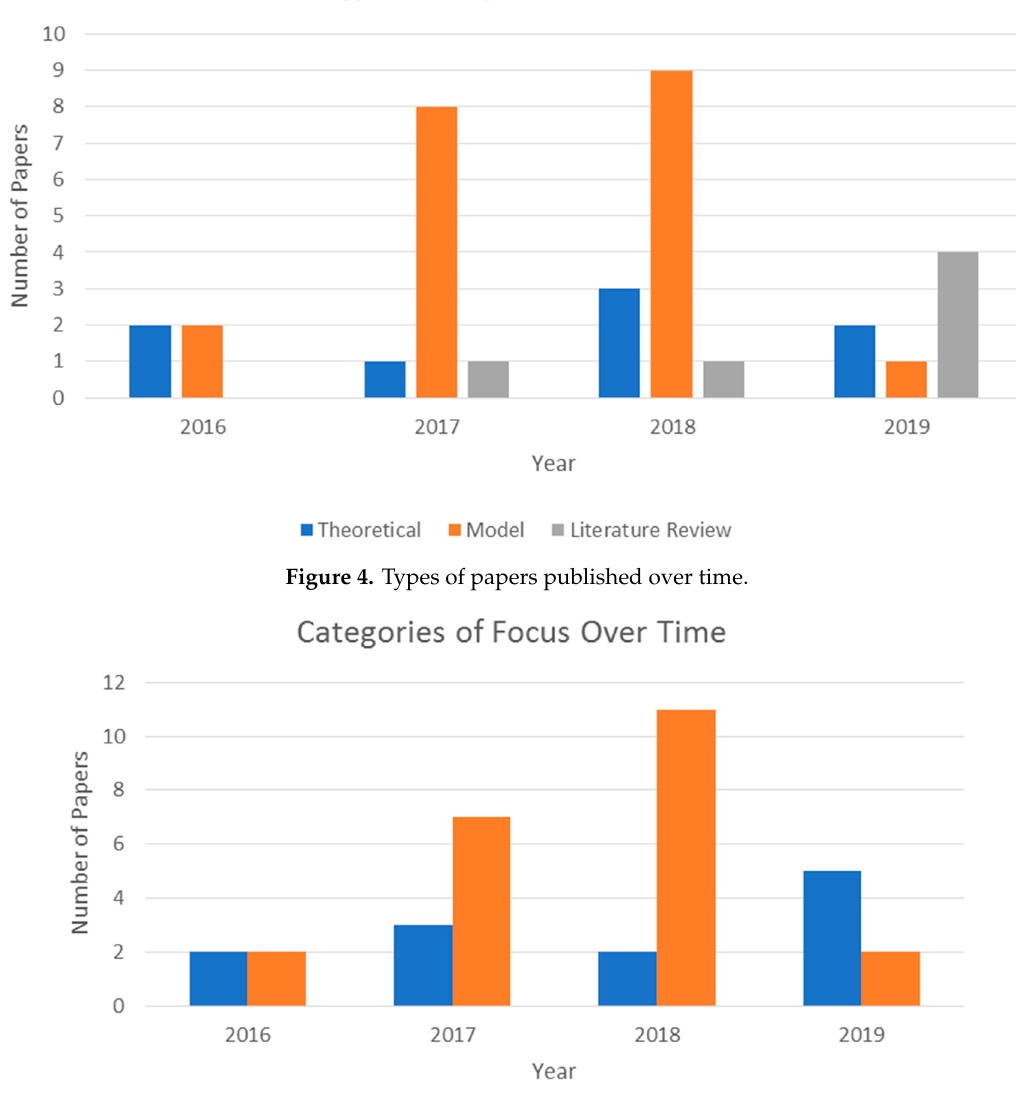
Figure 4. Types of papers published over time.